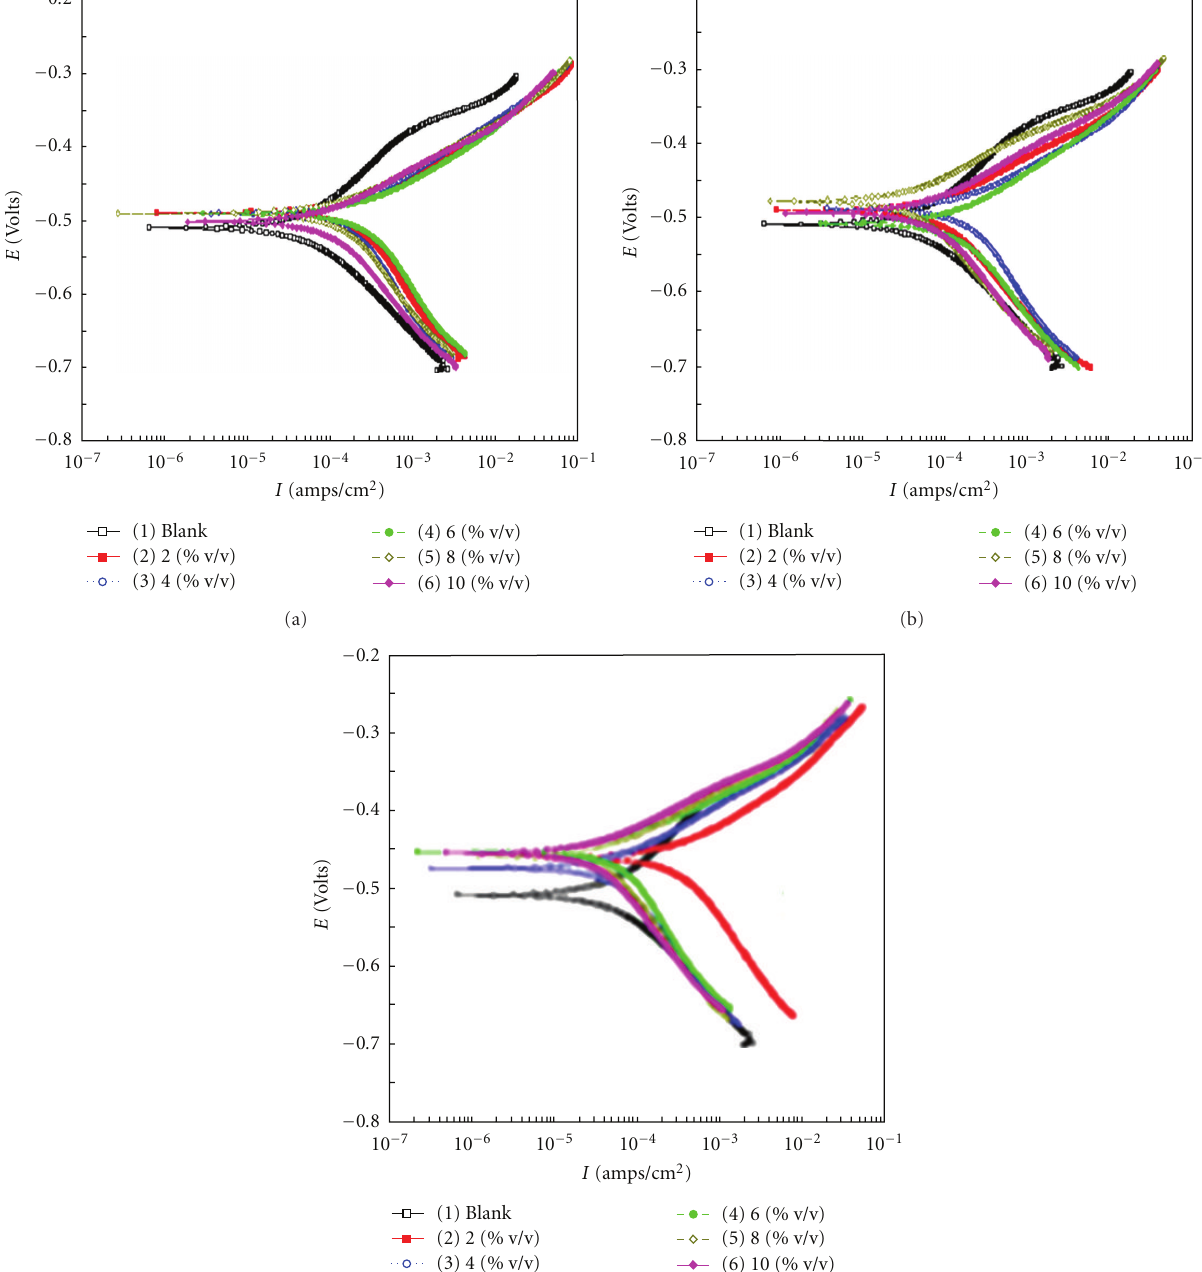
markedly decreased with the addition of the extract and the corrosion potential shifts to less negative values upon addition of the plant extract. Moreover, the values of anodic and cathodic Tafel slopes ( b a and b c ) are slightly changed indicating that this behavior reflects the plant extracts’ ability to inhibit the corrosion of mild steel in 1N HCl solution via the adsorption of its molecules on both anodic and cathodic